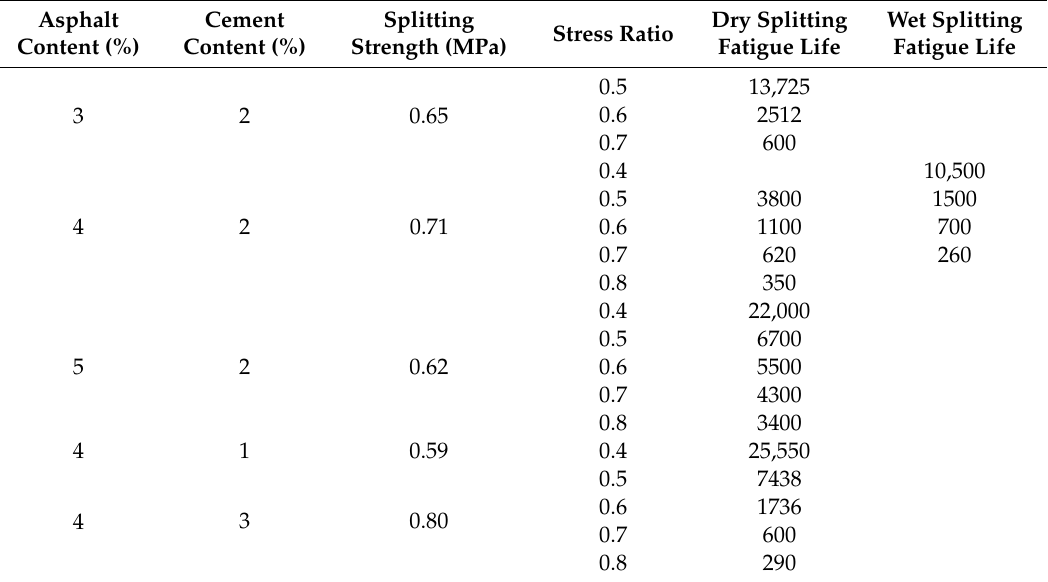
Table 7. Fatigue times of recycled materials with di ff erent